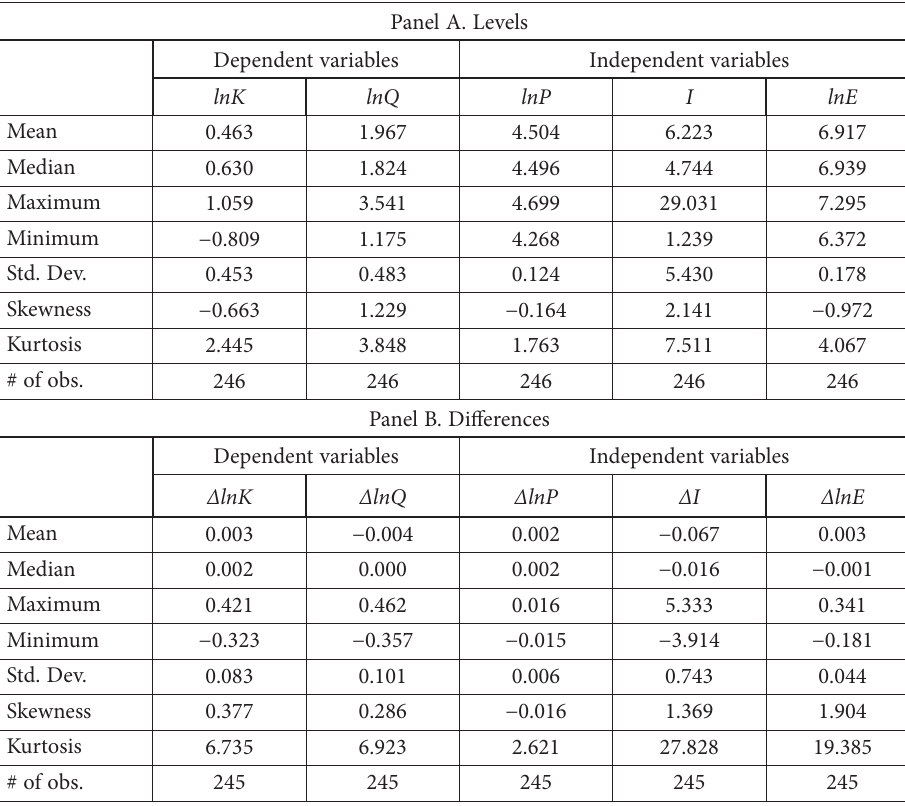
Table 1. Summary statistics